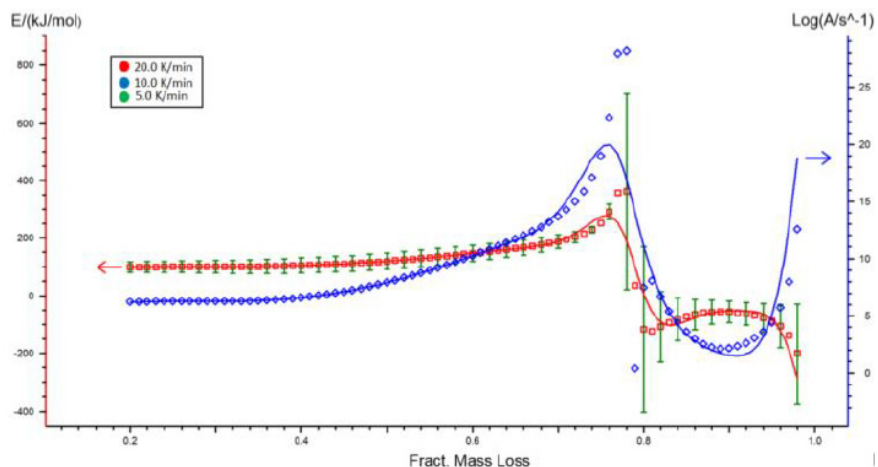
Figure 7. Pre-exponential coefficient and activation energy of Ozawa–Flynn–Walla conversion for Miscanthus. Table 3. Pre-exponential coefficient and activation energy as a function of the degree of conversion by the Ozawa–Flynn–Walla method for Miscanthus. Using the Netzsch Kinetics 3 program, based on thermogravimetric TG curves esti- mated as a function of temperature, a mathematical adjustment of one thermal depoly- merization reaction model was made. By using the estimated reaction model, kinetic pa- rameters were delivered, that is to say, the velocity constant (pre-exponential factor) k and activation energy E a , in addition to the fitting factor R 2 in Table 4. The most optimal fit for the experimental data for the Miscanthus sample was found for the n-order reaction model shown in Appendix A, Table 7 for n = 2.9. The correlation coefficient R 2 was 0.9932, the pre-exponential coefficient 10.42, and the activation energy 142.52 kJ/mol. Figure 8 represents the fit of the equation with estimated coefficients fitted to the experimental data. Table 4. Proximate and ultimate analysis of Miscanthus before and after the torrefaction process. Energy Crop